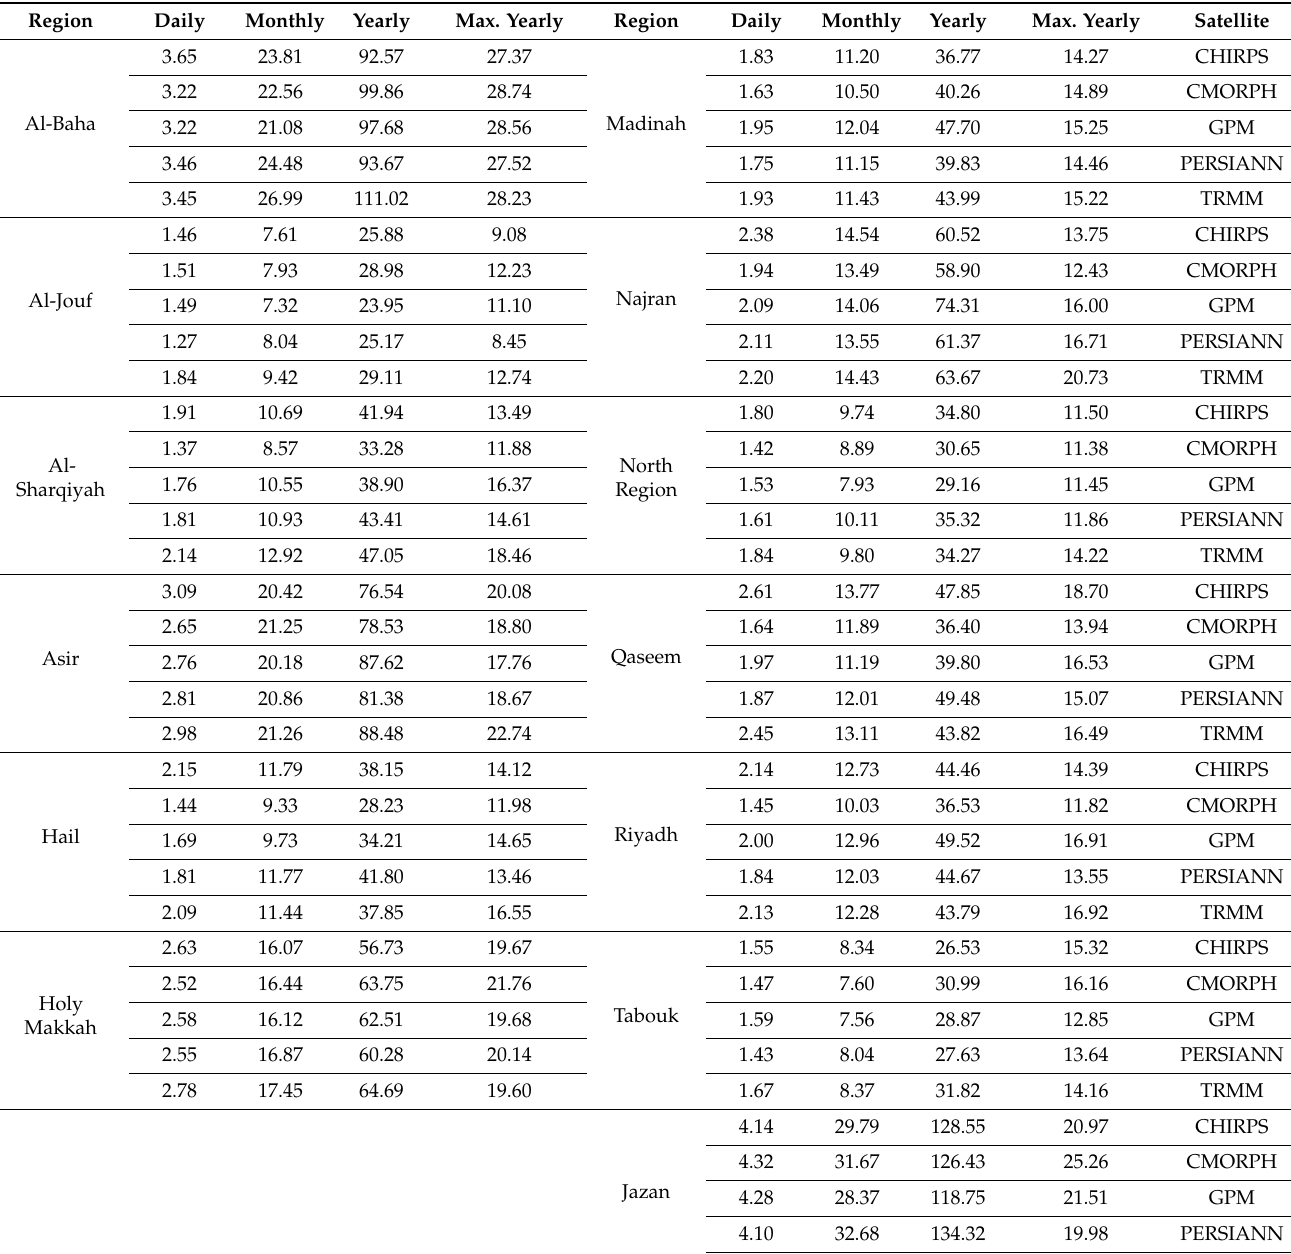
Table 6. Variation of RMSEc values for each region in the study area